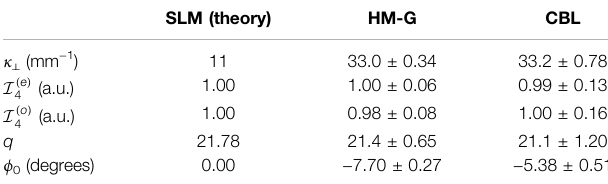
TABLE 1 | Consolidation of parameters measured from angular spectra of the M-GpumpbeamandtheCBL;theparametersusedforsimulatingthechosen illustrative mode, displayed in Figure 2 , are shown for reference.